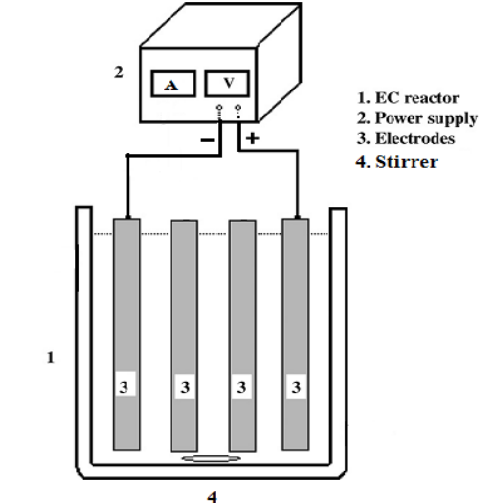
Figure 2. The schematic view of electrochemical